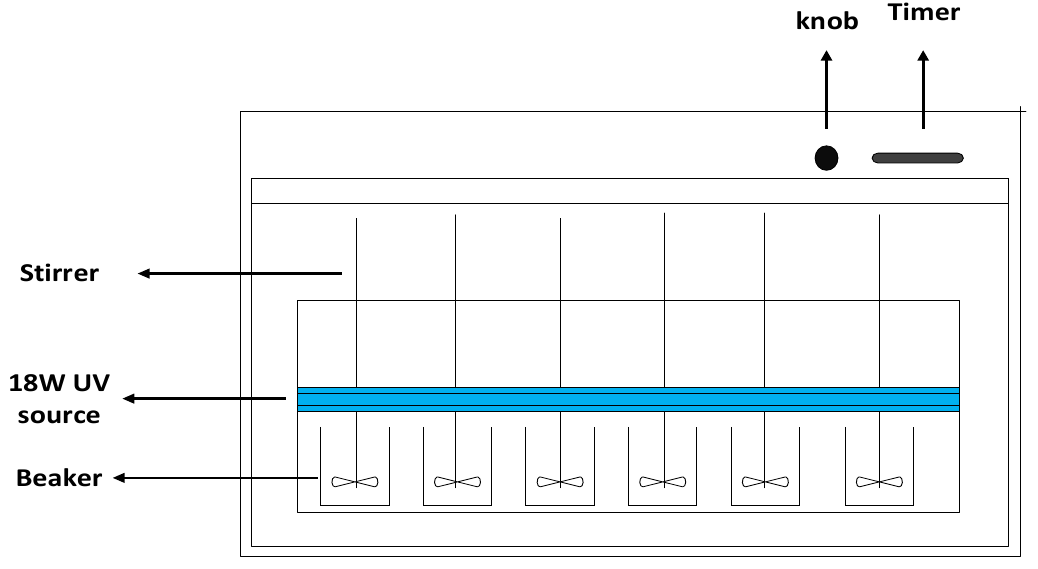
Figure 3. Experimental set up; jar testing apparatus.